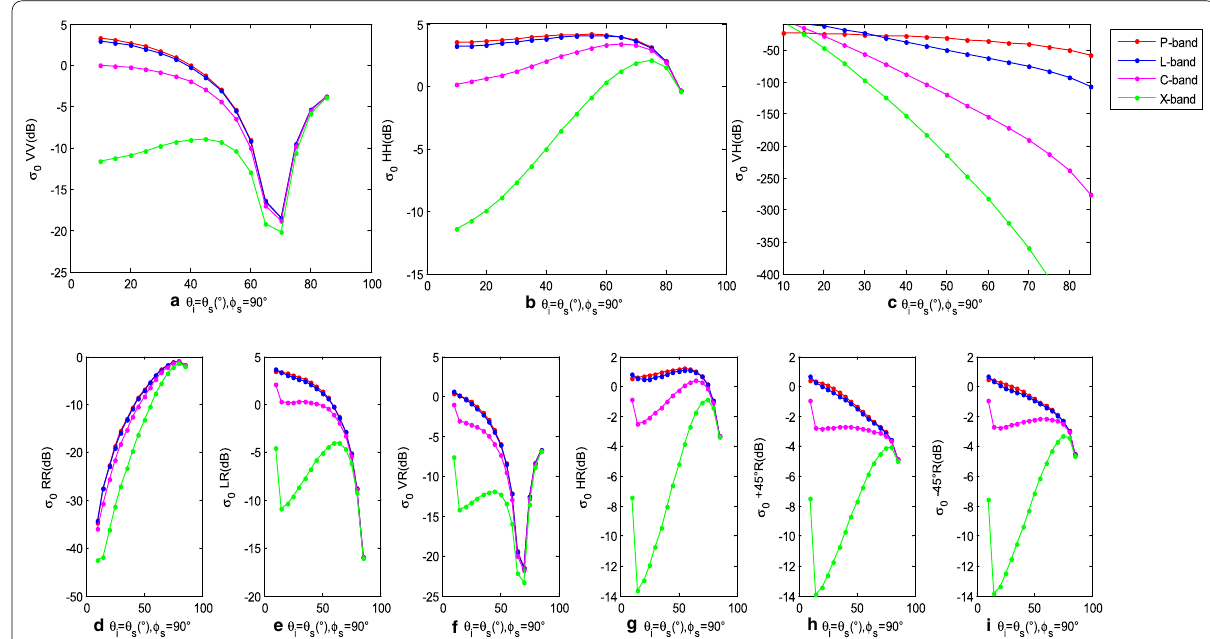
Fig. 7 Various polarizations random rough surface scattering cross section versus scattering angle for P-,L-,C- and X-band at perpendicular plane